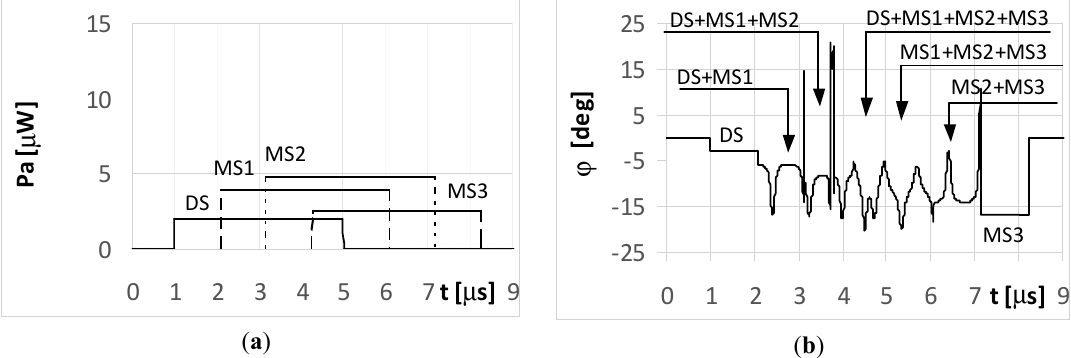
Figure 14. Envelopes of the direct signal (DS) and multipath signals (MS1, MS2, MS3) reflected from the ground, overlapping in time, and reaching UAV2 (shown in Figure 1) ( a ), and temporary angle of arrival ϕ estimated from the received resultant signal ( b ), (radar transmits LFM-type long pulsed signal with duration t i = 4 µ s , initial phases Φ 0D = Φ 01 = Φ 03 = 0, Φ 02 = 180 ◦ , and deviation ∆ f = 5 MHz; AOA was estimated using the monopulse phase method from the DF device installed on UAV2 ).